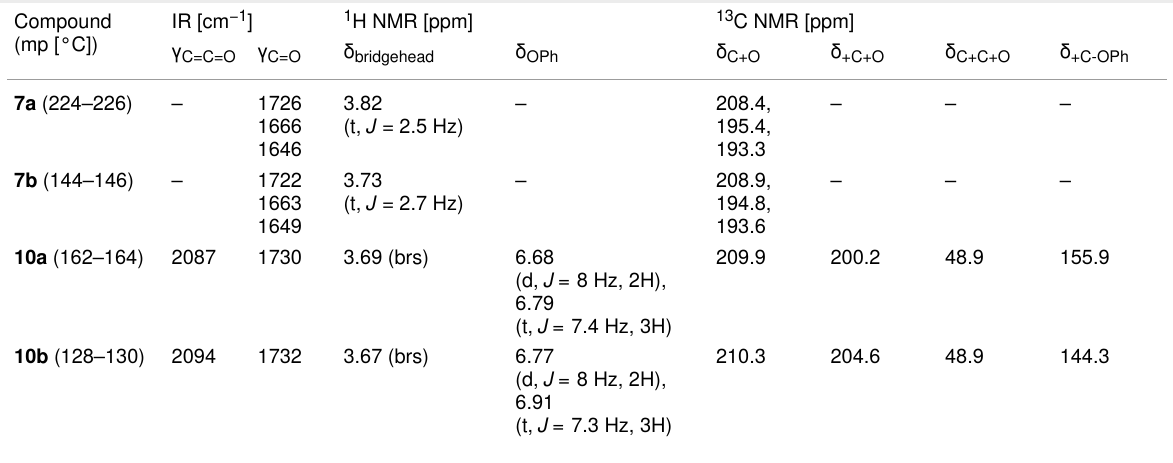
Ketenes 10a , b were exceptionally stable both in air and solu- tion. Their stability studies in acetonitrile through time-depend- ent absorption spectra (Figure 3) revealed that they remained almost unchanged at least for six to eight weeks. Such photoinduced intramolecular 1,5-phenyl migration from carbon to proximate oxygen is a general reaction route for ( cis )- dibenzoylalkene chromophores [19-22]. In unsymmetrical derivatives such migrations have been found to take place from the benzoyl group attached to the more crowded olefinic carbon atom to the less crowded one [23]. A similar observation has been reported from our laboratory for bicyclo[2.2.2]octenone systems [13]. Thus, selective formation of 10a , b is expected with the exception that the ketenes 10a , b were unusually stable. This may be due to the imposition of the bulky electron-withdrawing group at the bridgehead